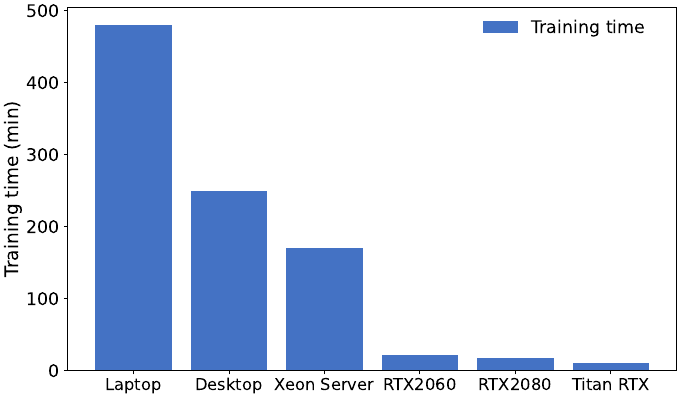
Figure 10. The training time (minutes) per epoch on different devices.